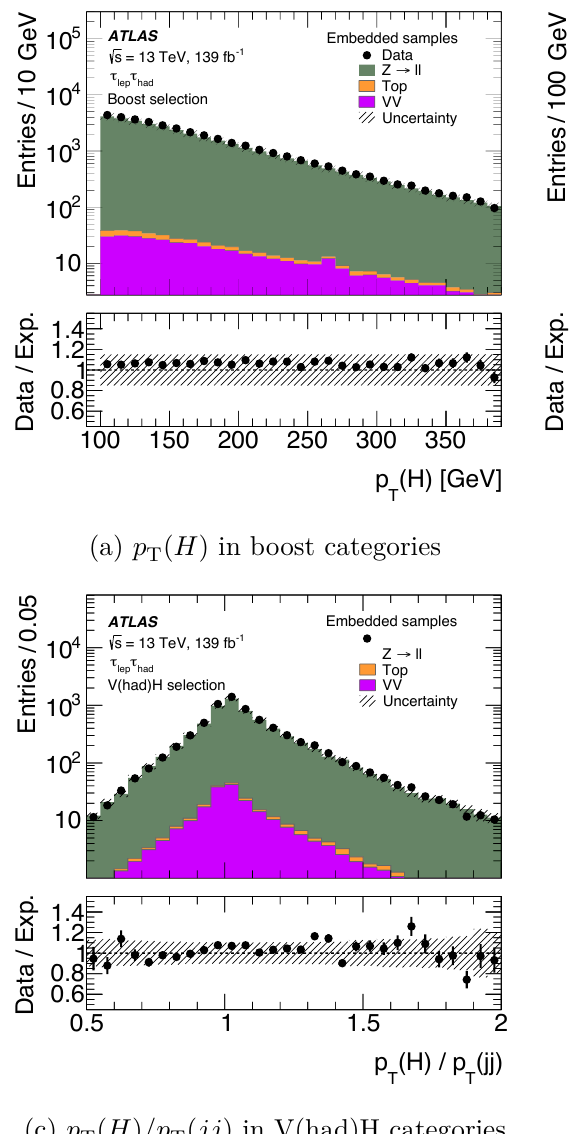
Figure 5. Comparison between MC simulation prediction and data in the Z ( → ‘‘ ) + jets-enriched control regions. The embedding procedure is applied to the data and simulation samples to mimic the τ τ event selection: (a) p ( H ) in the boost categories, (b) m in the VBF categories and lep had T jj (c) p ( H ) /p ( jj ) in the V(had)H categories. The bottom panels show the level of agreement between T T the embedded data and the embedded simulation samples. The uncertainty is the sum in quadrature of the statistical uncertainty of the simulated events and the systematic uncertainties of the simulation. Only the acceptance uncertainties in each category are considered. The shape variations, translating to potential bin-by-bin changes, were estimated to be minor and are not